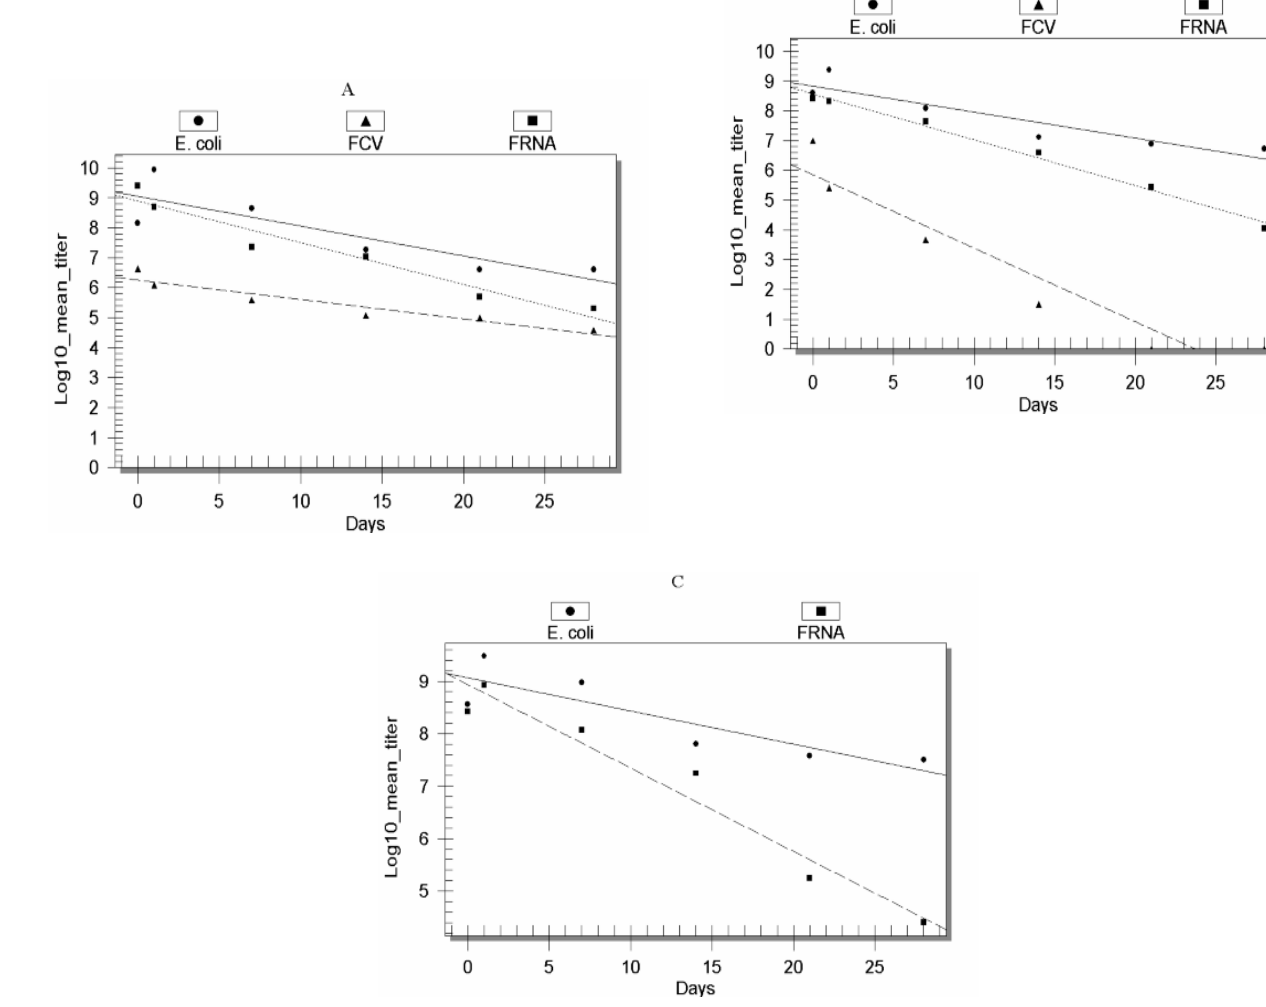
Figure 1: Survival curves with fitted regression lines for E. coli , F-specific coliphage MS2, and feline calicivirus in tap water at 4 ° C (A), 25 ° C (B), and 37 ° C (C). Regression lines were fitted to curves that consisted of at least 4 data